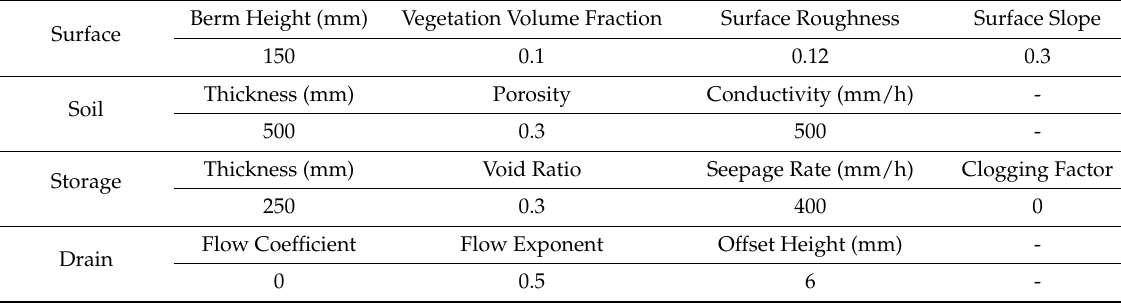
Table 3. Parameters of rain garden in